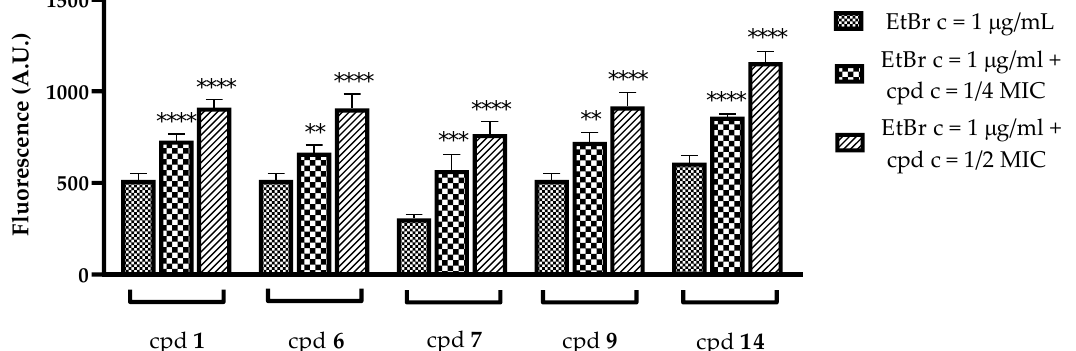
Figure 3. Fluorescence intensity of EtBr (1 µg/mL) after addition of compounds 1 , 6 , 7 , 9 and 14 at 20-min time point in S. epidermidis K/14/1345. Statistical significance was calculated using a one-way analysis of ANOVA, followed by the multiple comparison test (** p < 0.05, *** p < 0.001, **** p < 0.0001).